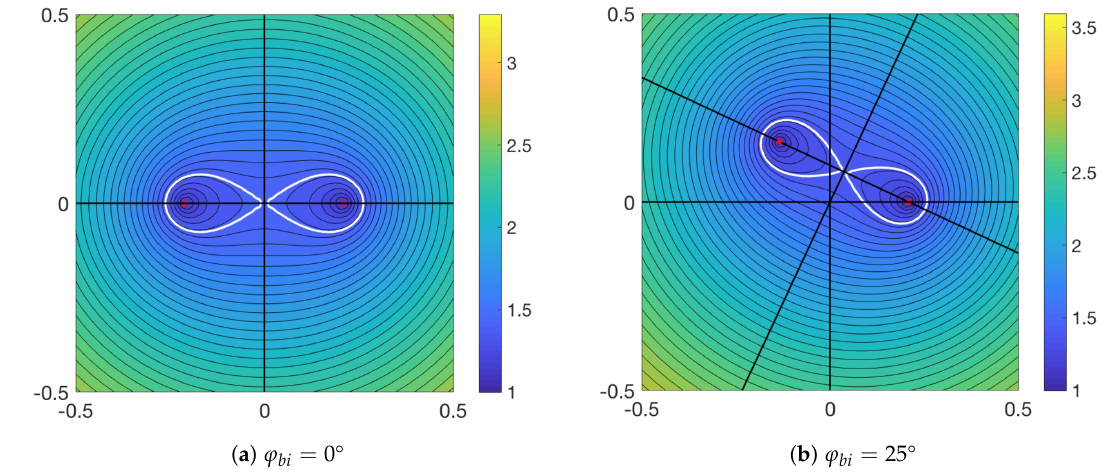
Figure 7. The frequency contours of Equation (36) for two values of ϕ bi , ( a ) monostatic ϕ bi = 0 and ( b ) bistatic angle ϕ bi = 25° when m = m (cid:48) = 1. The normalised frequency, η = ω / ω B , is shown by the colour, in the p , q